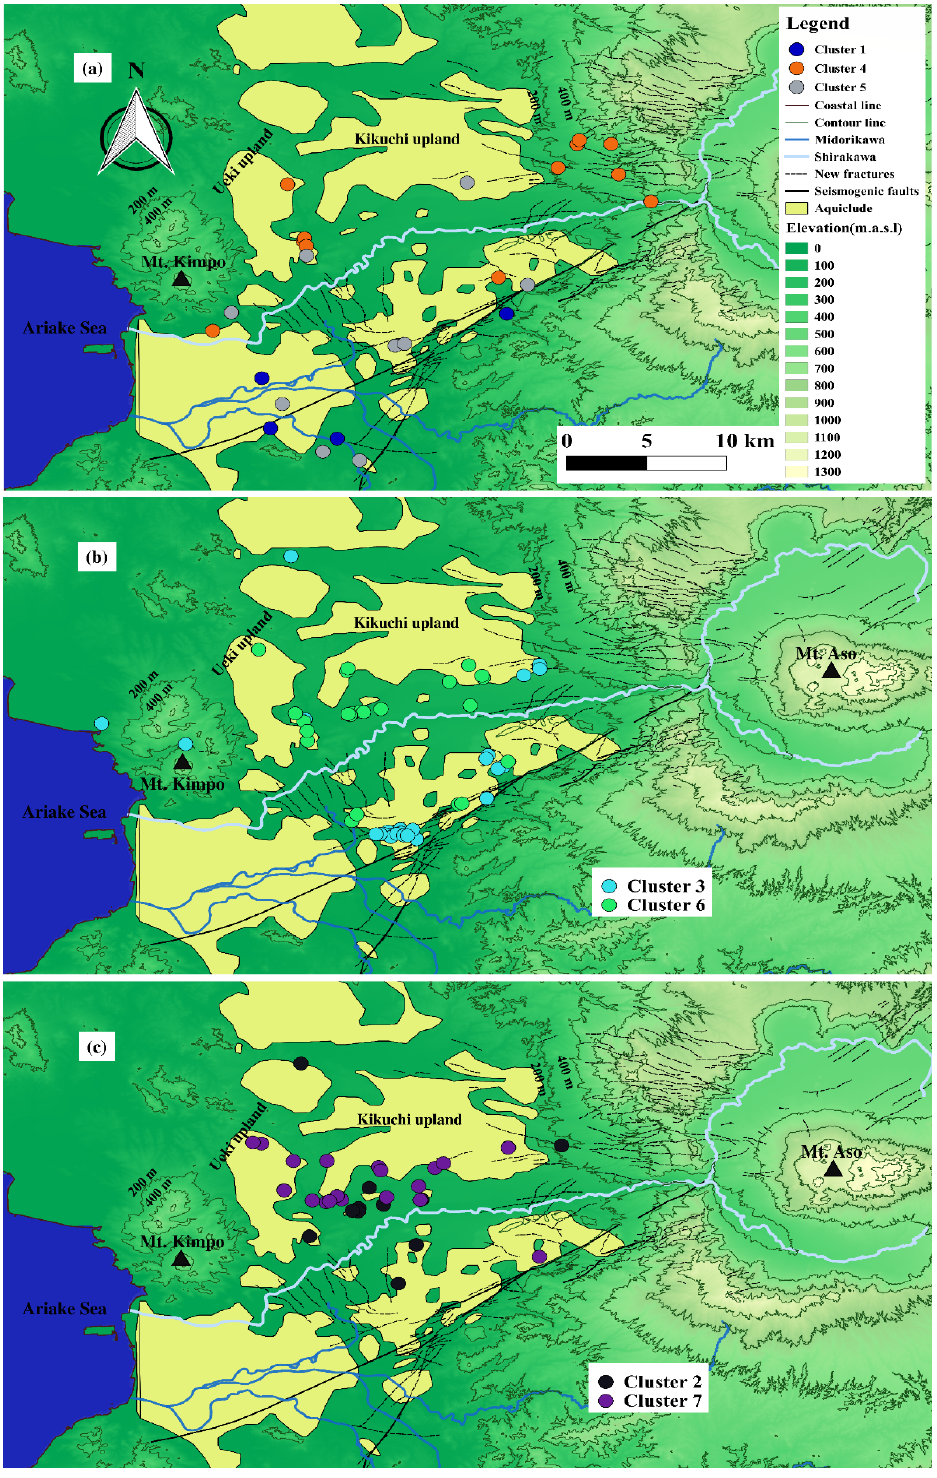
Figure 8. Spatial distribution of each SOM cluster. Aquiclude refers to the clay layer between unconfined and confined aquifers. ( a ) Cluster 1, 4, and 5 ( b ) Cluster 3 and 6 ( c ) Cluster 2 and 7.